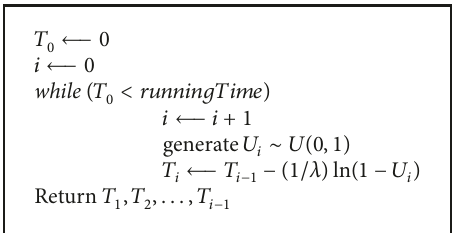
Algorithm 1: Algorithm for simulating a Poisson Process with Exponential interarrival times between disruption